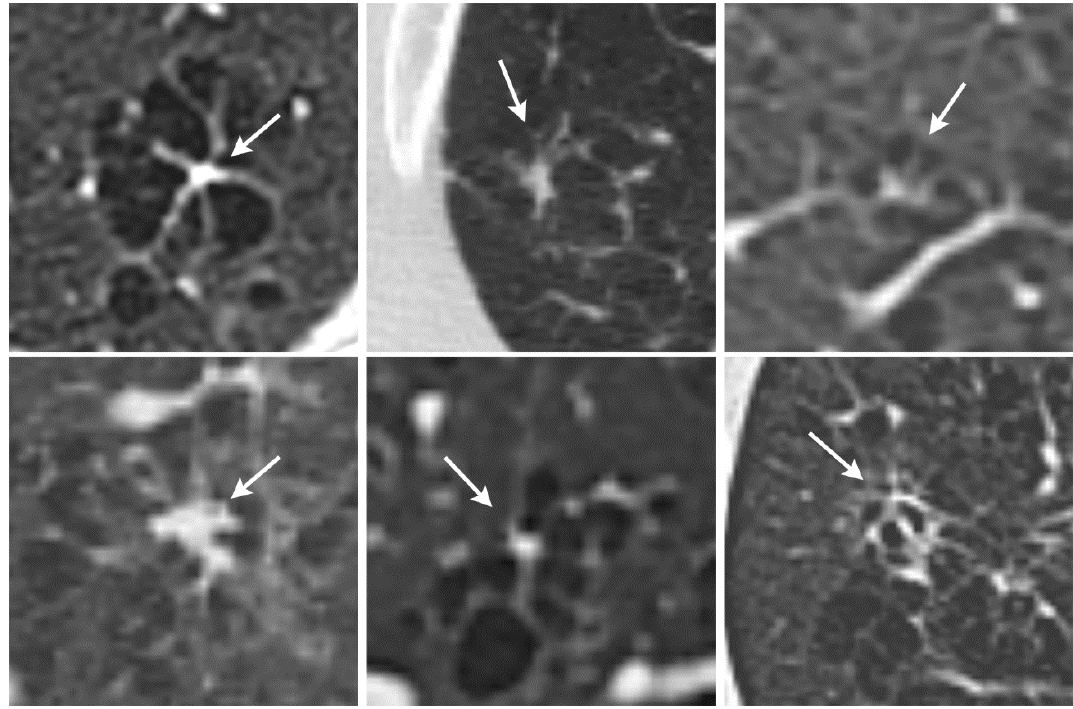
Figure 2. The octopus sign (arrows) in six different patients with Langerhans cell histiocytosis (stage 2).